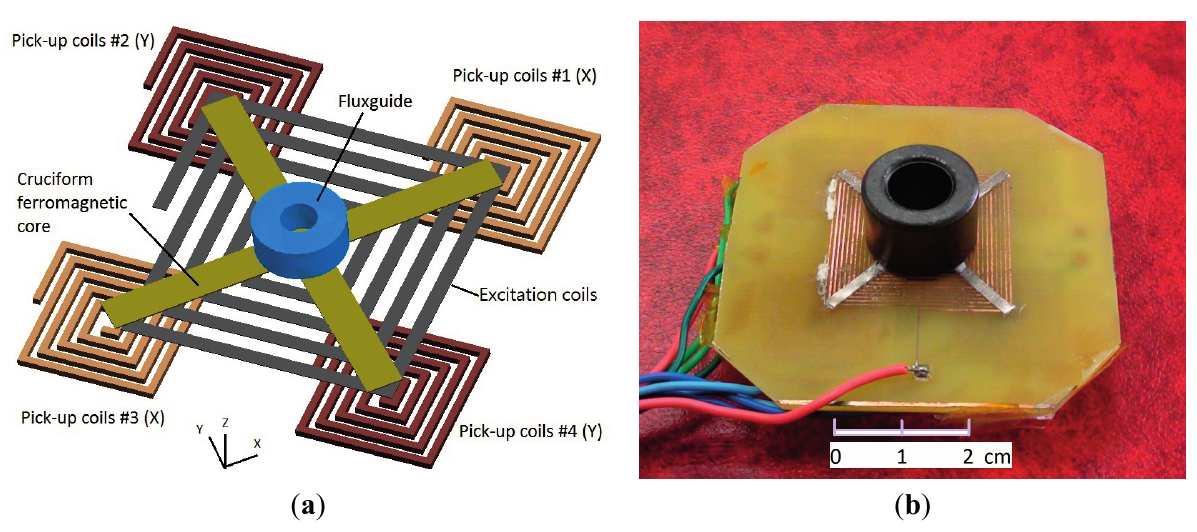
Figure 1. ( a ) Conceptual schematic of the planar fluxgate structure with an orthogonal fluxguide; ( b ) the PCB-based tri-axis fluxgate magnetometer. Note that all pick-up coils are implemented on the back side of the